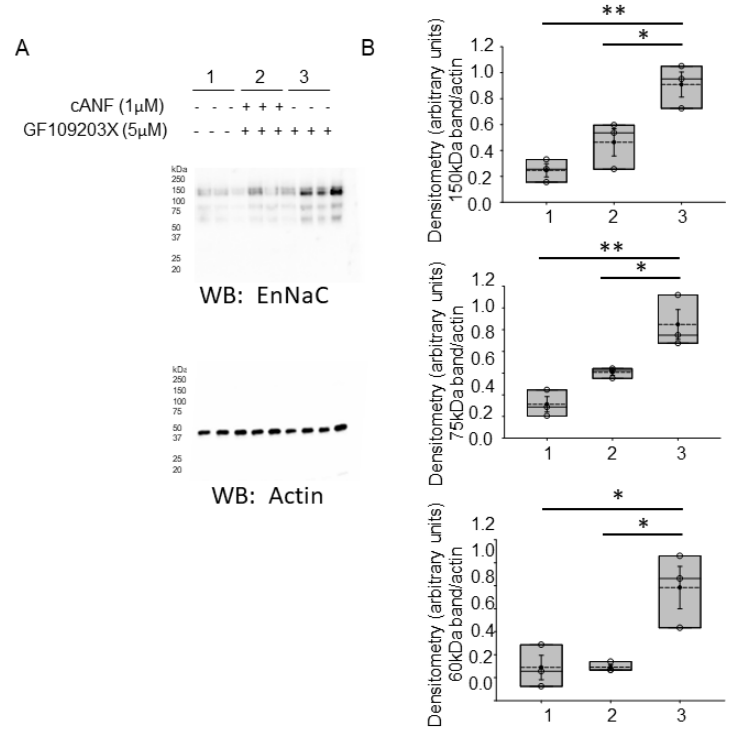
Figure 6. EnNaC alpha protein expression after inhibition of PKC. ( A ). Western blot for EnNaC alpha protein after hAoECs were treated with or without the PKC inhibitor GF109203X and with or without the NPRC agonist cANF for 3 h. ( B ). Densitometric analysis of the 150 kDa, 75 kDa, and 60 kDa immunoreactive bands in ( A ). A Student’s t -test was performed to make comparisons between the two groups. n = 3 samples for each of the three groups. * Represents a p -value < 0.05. ** Represents a p -value <